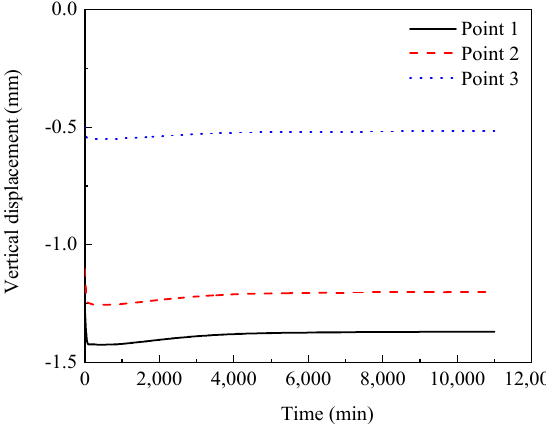
Figure 20. Contours of vertical displacement at the steady state (time is 11,000 min) of fluid flow (unit: mm). Figure 21. Evolution curves of the vertical displacement in saturated zone of railway subgrade.